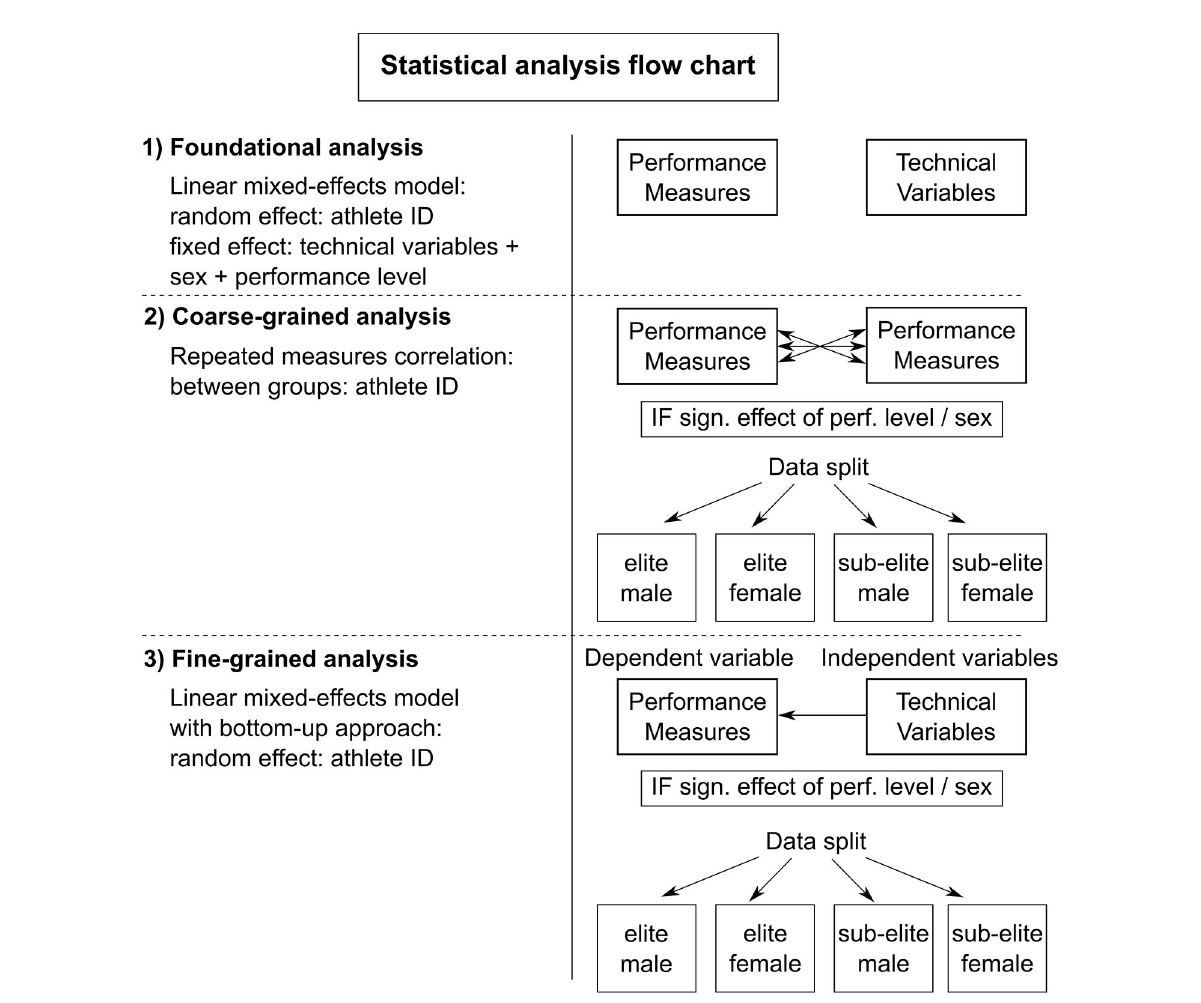
FIGURE2 Flow chart of the performed statistical analysis. 1) Foundational analysis to investigate the effect of performance level and sex on the performance measures and technical variables. 2) Coarse-grained analysis to determine the level of association between the performance measures. 3) Fine-grained analysis to examine the relationship between each performance measure and the selected technical